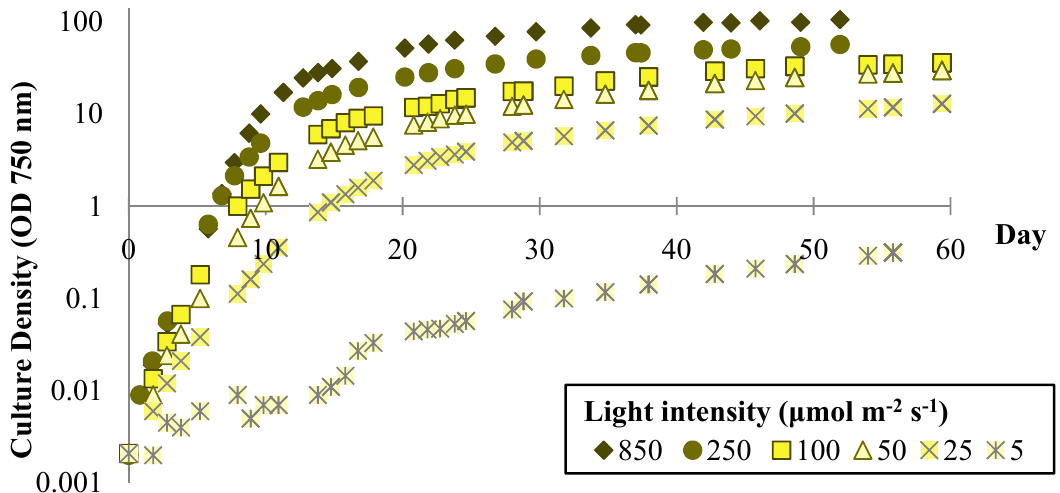
Figure 1. Biomass concentration (OD750) as a function of time in photobioreactor cultures operated at six different light intensity set points. (Note logarithmic scale, dry weight , r 2 > correlation was: AFDW (g/L) = 0.185 × OD 750